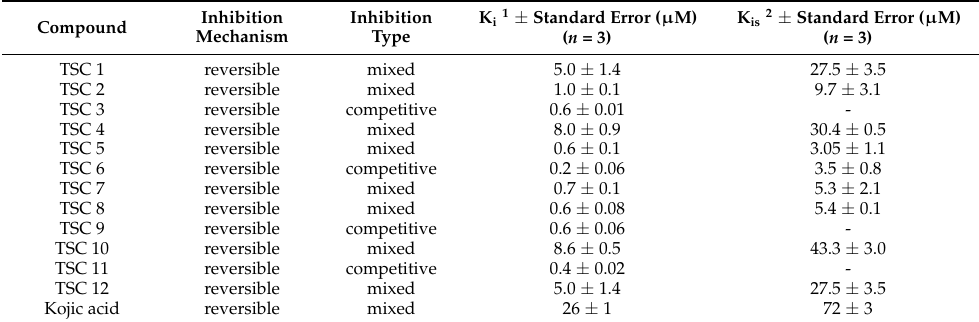
Table 2. Inhibition type, mechanism, and the inhibition constant values of the examined compounds on the diphenolase activity of mushroom tyrosinase.